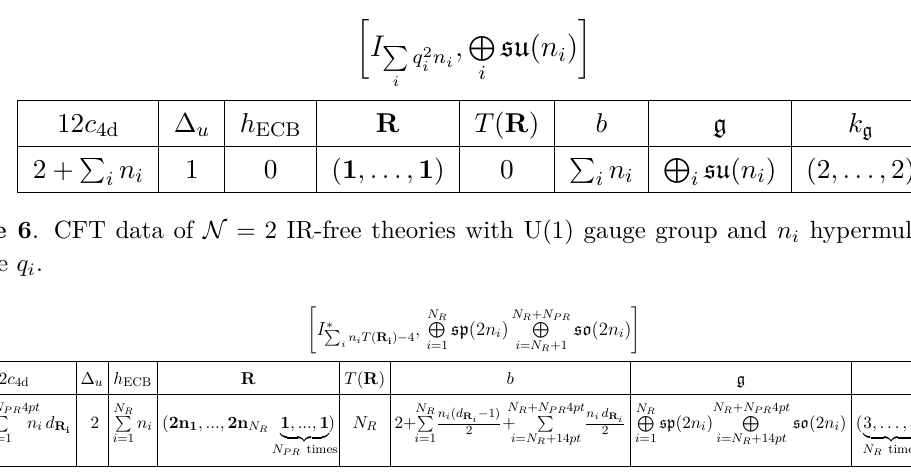
Table 7 . CFT data of N = 2 IR-free theories with a SU(2) gauge group and with N R real and indicates the dimension of the representation R N PR pseudoreal representations. d R i